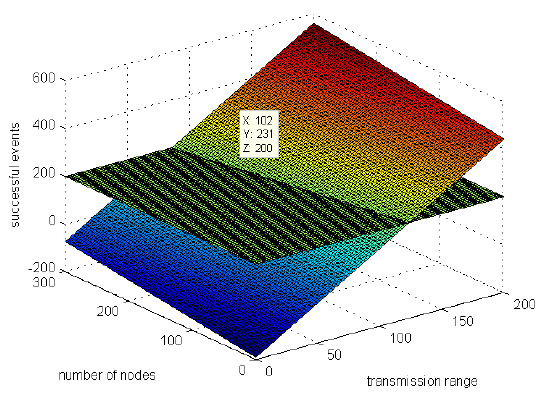
Fig. 12. Mean value for the number of successful events for EAST with neighborhood discovery as a function of the number of deployed nodes and the maximum transmission range with an intersecting plane with the value 200 successful